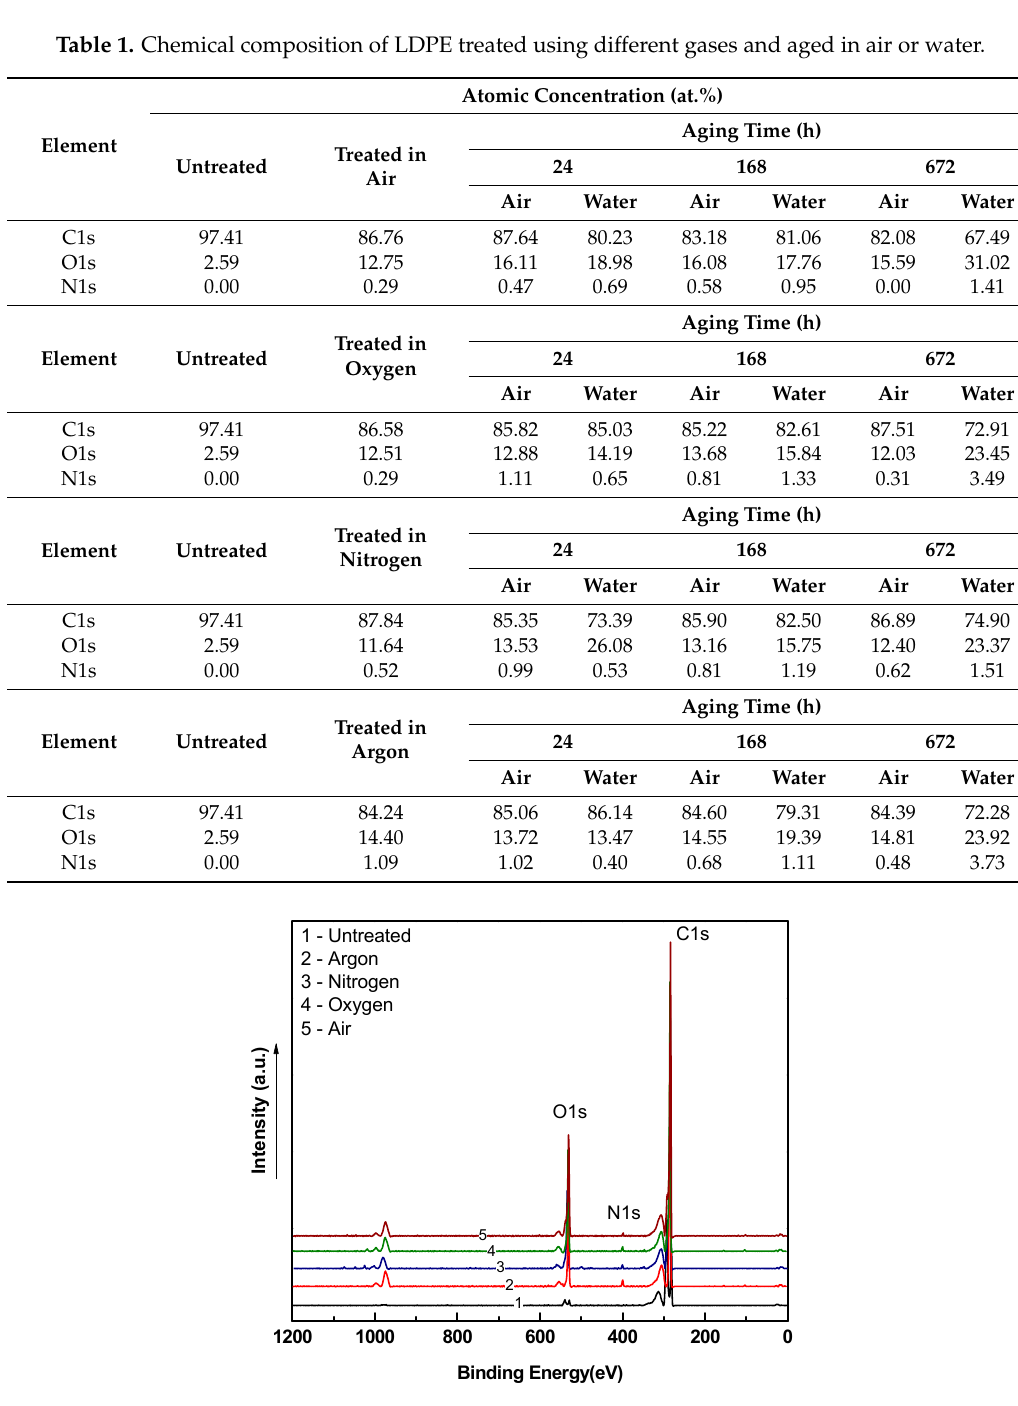
Figure 20. XPS spectra of plasma treated LDPE using different gases.